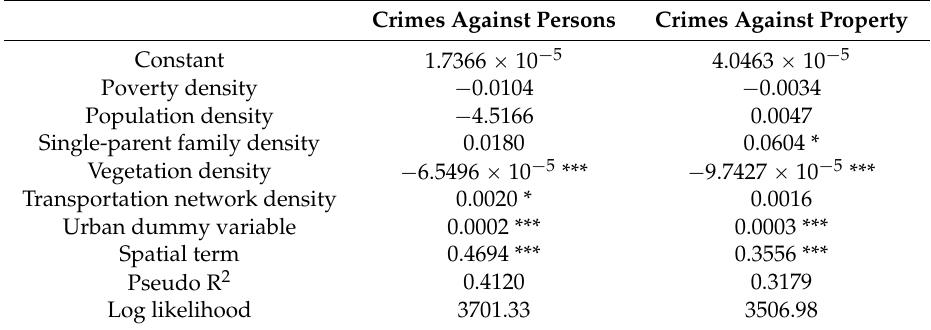
Table 6. Spatial regression results for crimes against persons and crimes against property at the urban central-peripheral